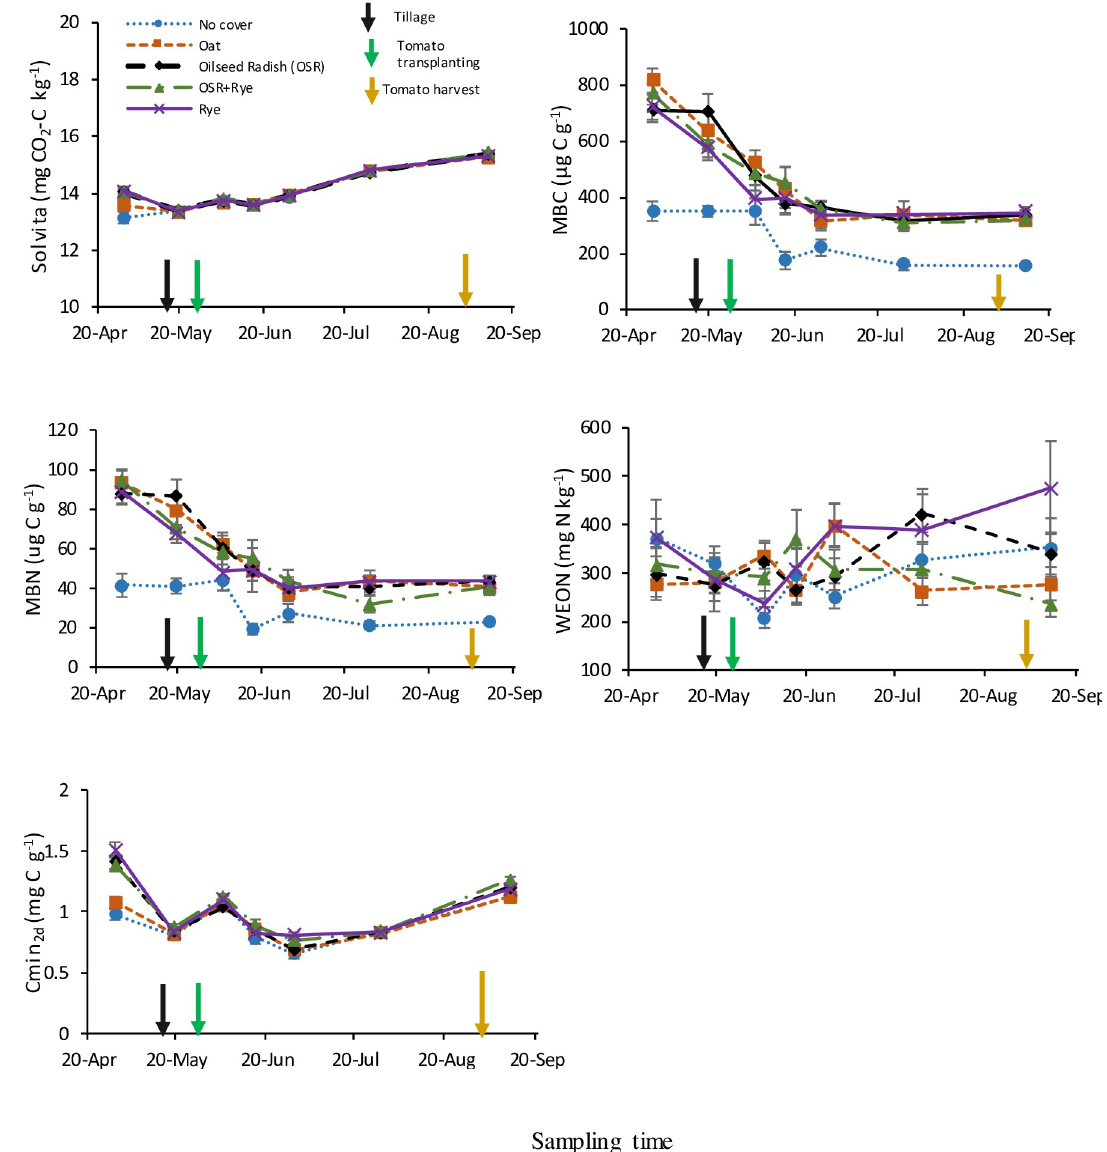
Fig 3. In site-year 2015, effect of medium-term summer-planted cover crop (6-yrs) on soil labile fractions of C and N from 0–15 cm depth over the tomato growing season. Bars represent standard error of means (n = 8). Cmin 2d , cumulative 2d soil C mineralization; MBC, microbial biomass C; MBN, microbial biomass N; WEON, water extractable organic